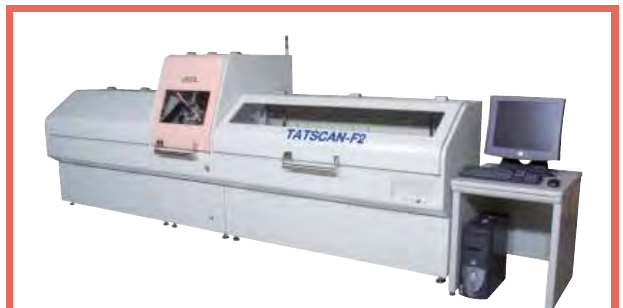
Figure 1. Photograph of the non-destructive XRF scanner,